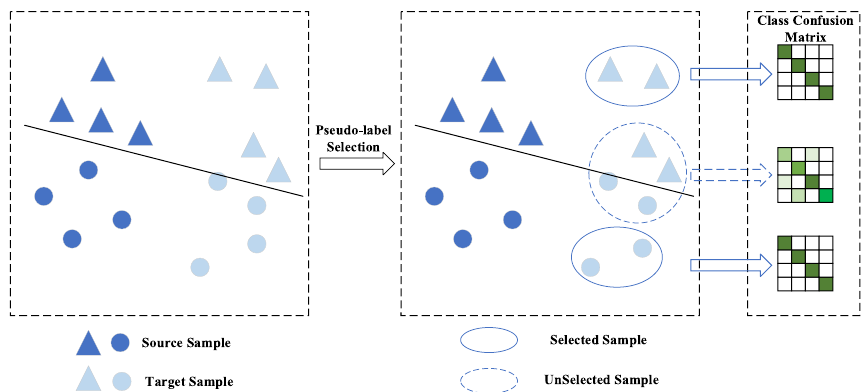
Fig. 4 Classification confusion matrices of selected and unselected samples in the target